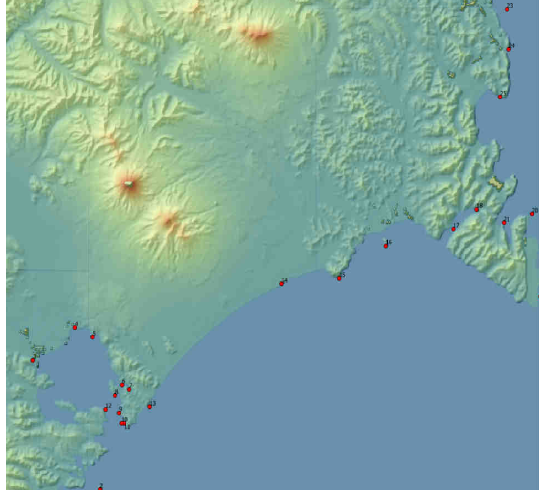
Figure 6. Points (red dots) selected for geolocation of ISS images. Zhupanovsky is in the figure above, in the middle left you can see also Koryaksky and Avachnisky